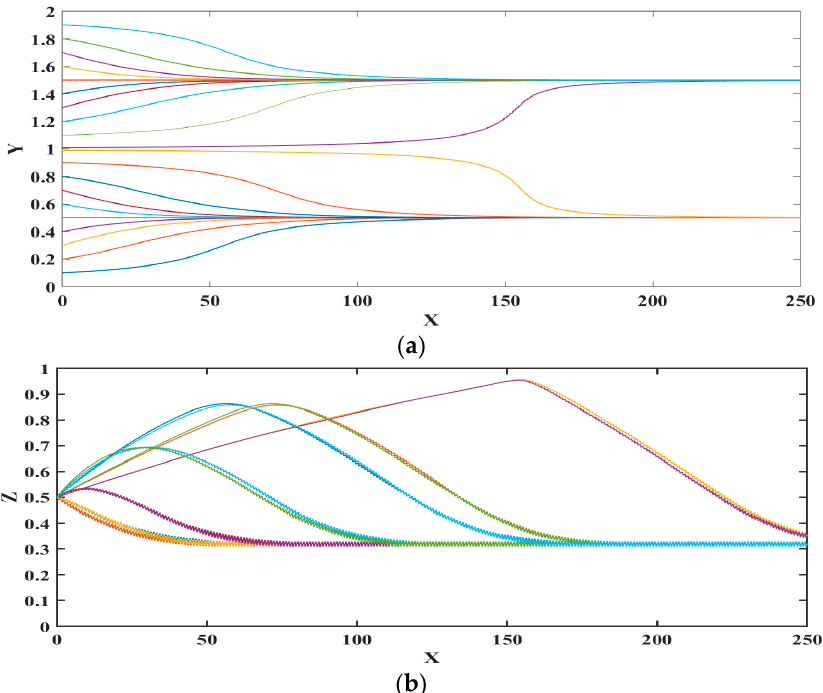
Figure 4. Trajectories of microparticle in the microfluidic device with different initial location along the y-axis ( a ) top view; and ( b ) side view. X, Y, and Z are the dimensionless lengths x/L, y/L, and z/Hch, respectively.